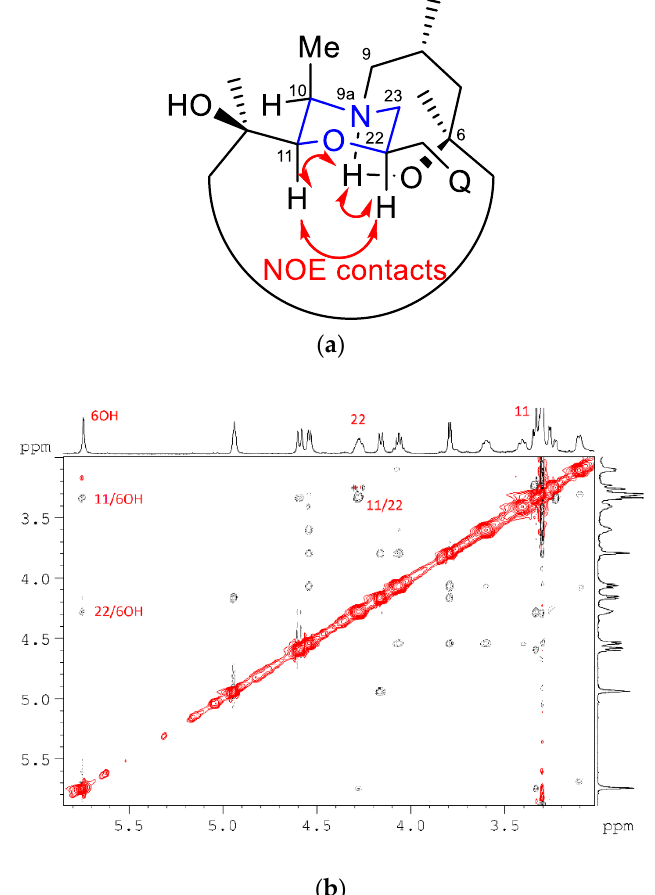
Figure 2. ( a ) NOE contacts observed in the ( b ) NOESY NMR spectrum of 10b confirming the R configuration of C-22.